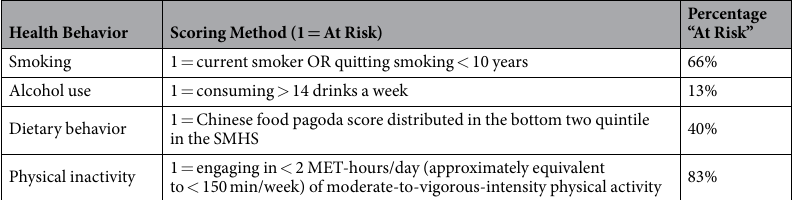
Table 1. Scoring of factors in the lifestyle risk index, the Shanghai Men’s Health Study (2002–2013, n =